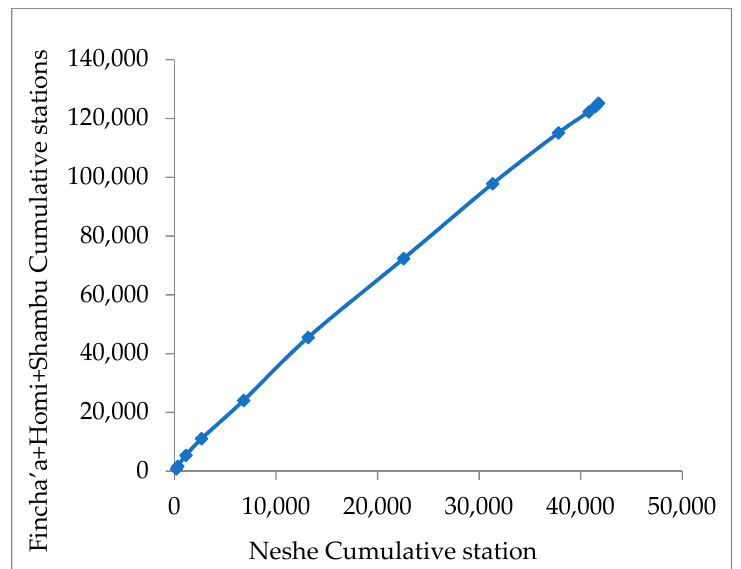
Figure 6. Double mass curve of the daily annual precipitation.